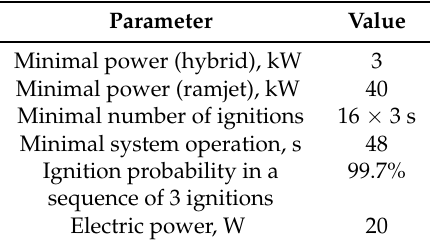
Table 1. Design criteria for the ignition system.